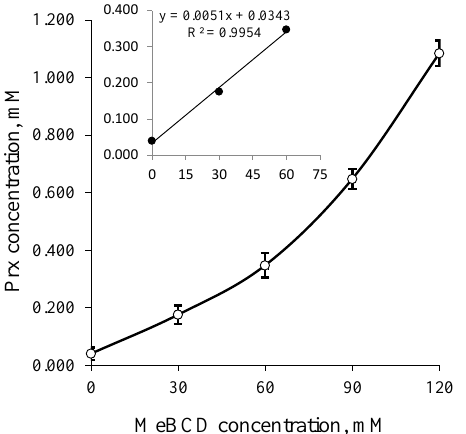
Figure 4. Phase solubility diagrams of Prx–MeBCD inclusion complexes; Insert: Up to 0–60 mM of MeBCD. MeBCD: 2,6-dimethylated-β-CD.